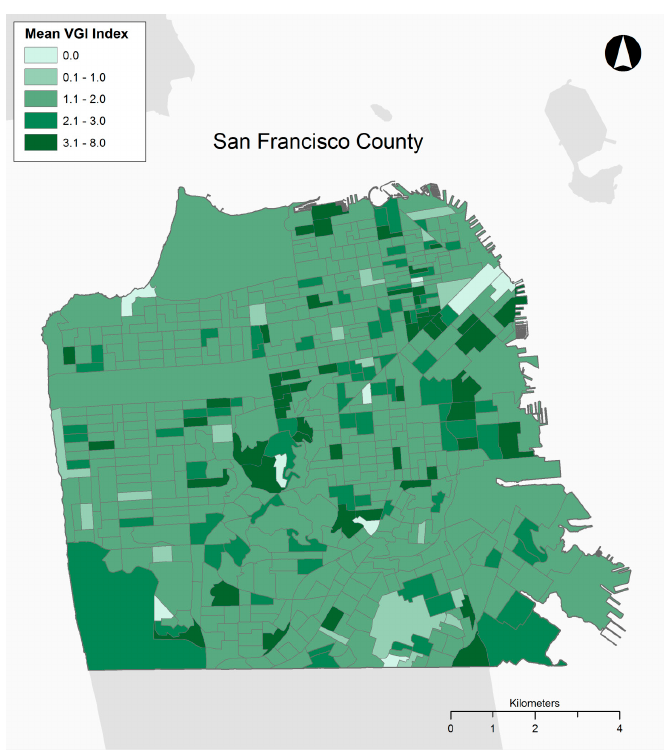
Figure 4. San Francisco mean VGI index (the mean number of attributes per VGI tree in each block group).